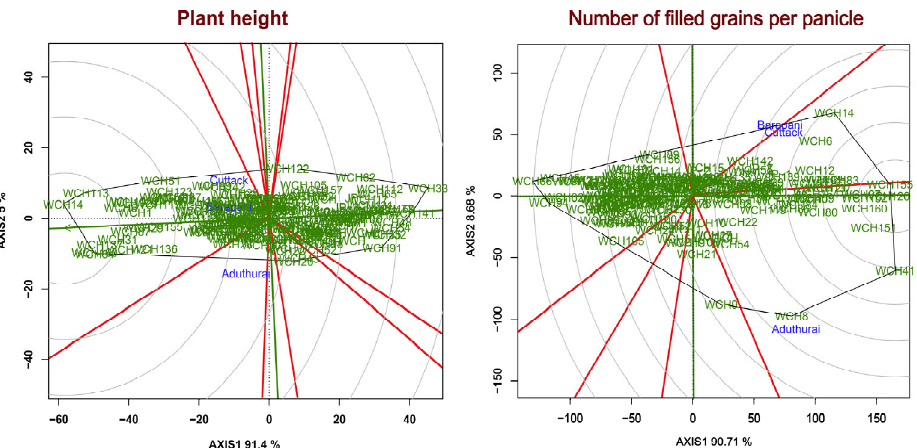
Figure 6. Combined biplots for multilocation performance wide compatible hybrids based on GGE biplot analysis on the most significant NPT related traits.